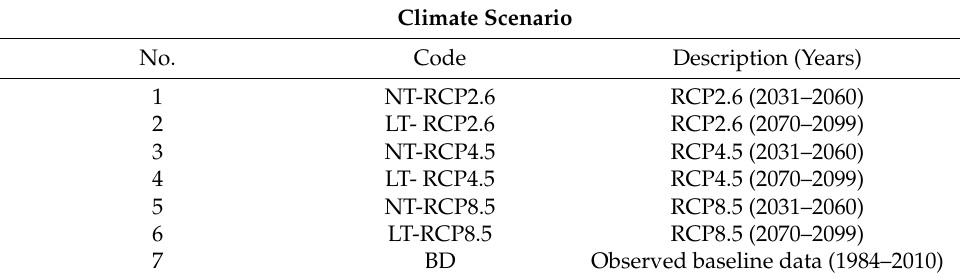
Table 5. Applied climate scenarios for analyzing the impacts of climate change on the major compo- nents of the water balance in the